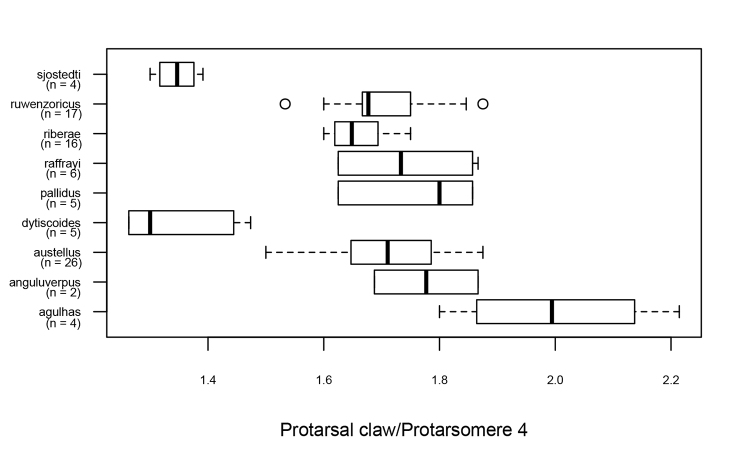
The ratio between length of protarsal claw and length of protarsomere 4 in males of the Agabus
raffrayi group. Symbols as in Fig. 12. Note the short claws of A.
sjostedti and A.
dytiscoides.